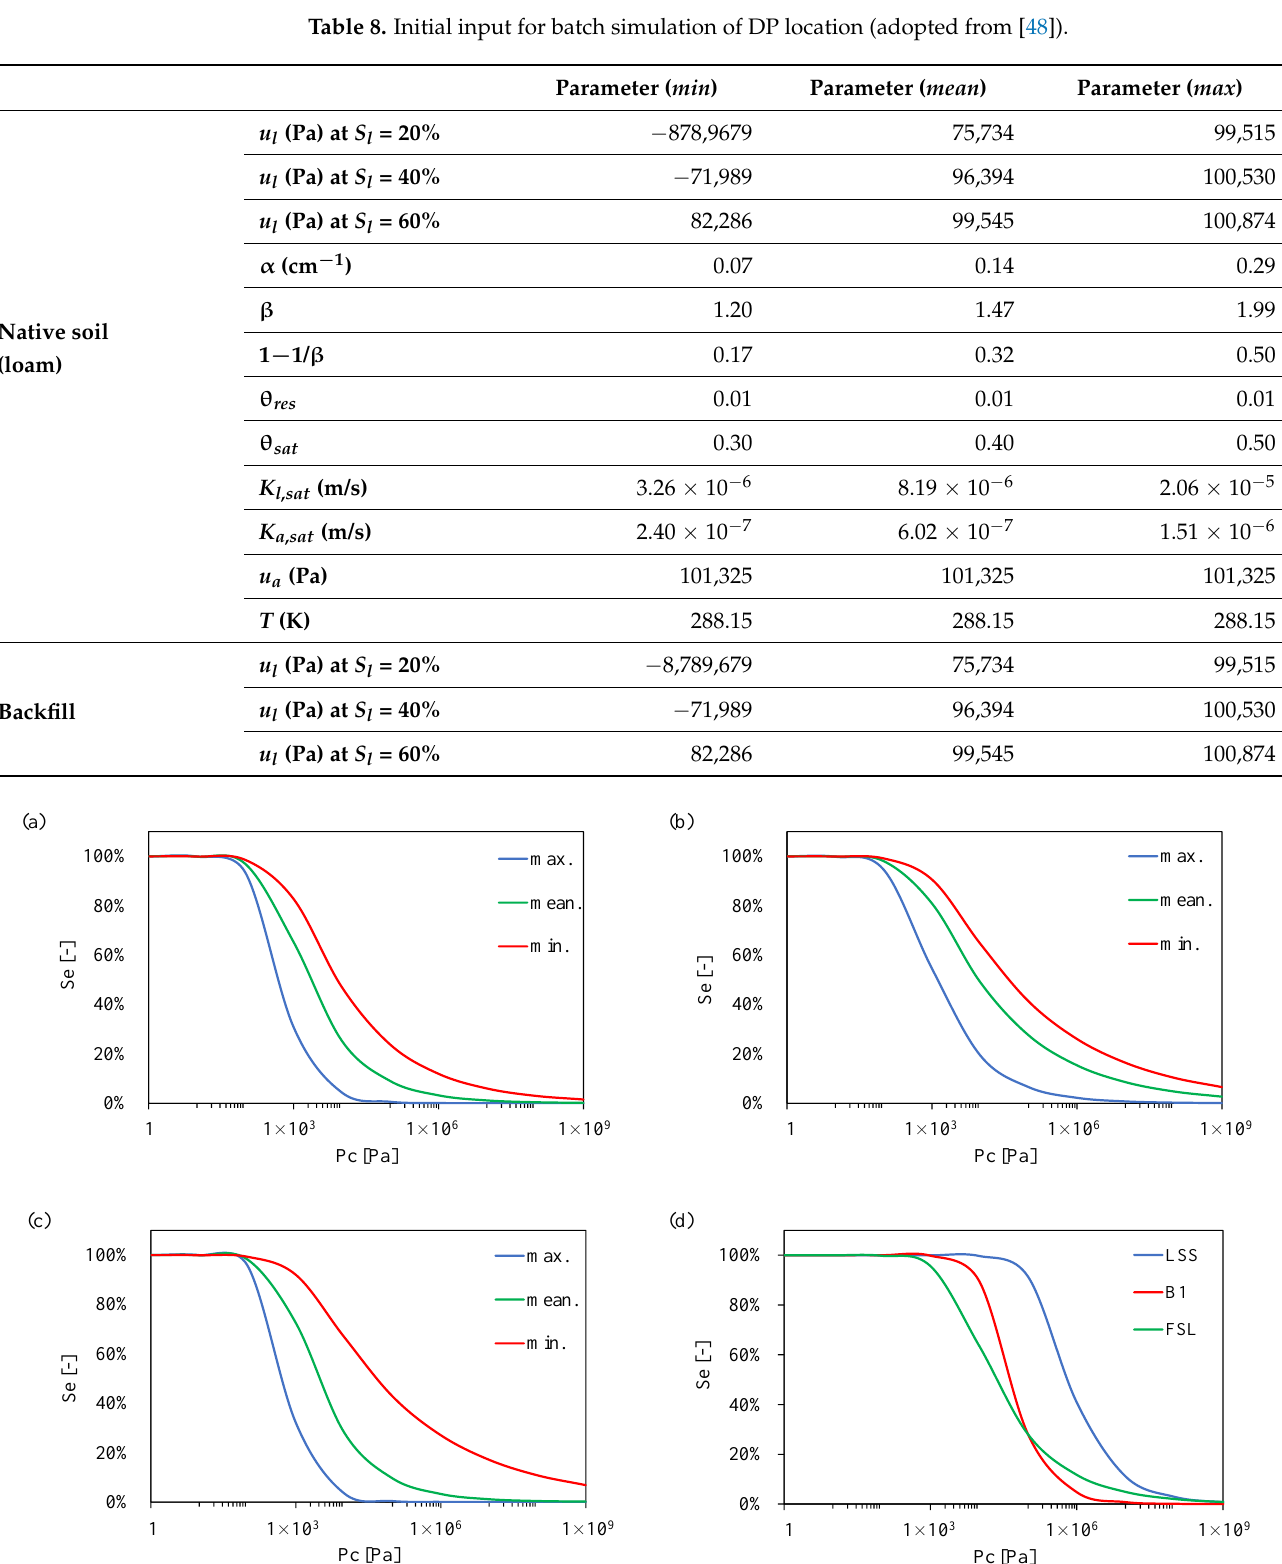
Table 8. Initial input for batch simulation of DP location (adopted from [48]).